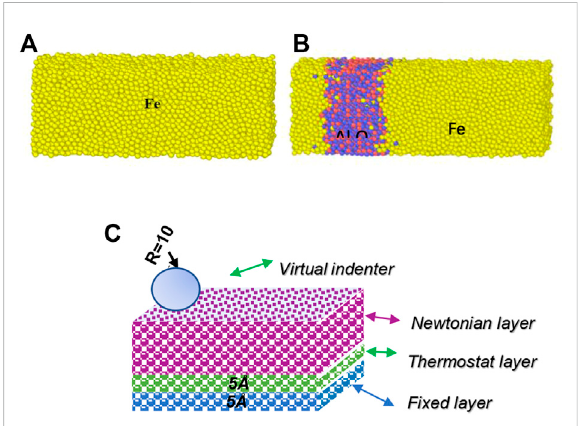
FIGURE 1 MD simulation models for friction and wear: (A) pure Fe- based amorphous model; (B) Al 2 O 3 /Fe amorphous composite model (example for 15 wt% Al 2 O 3 /Fe amorphous composite model); (C) front view of MD simulation model. (Atoms are colored by type: Fe in yellow, Al in red, O in blue).